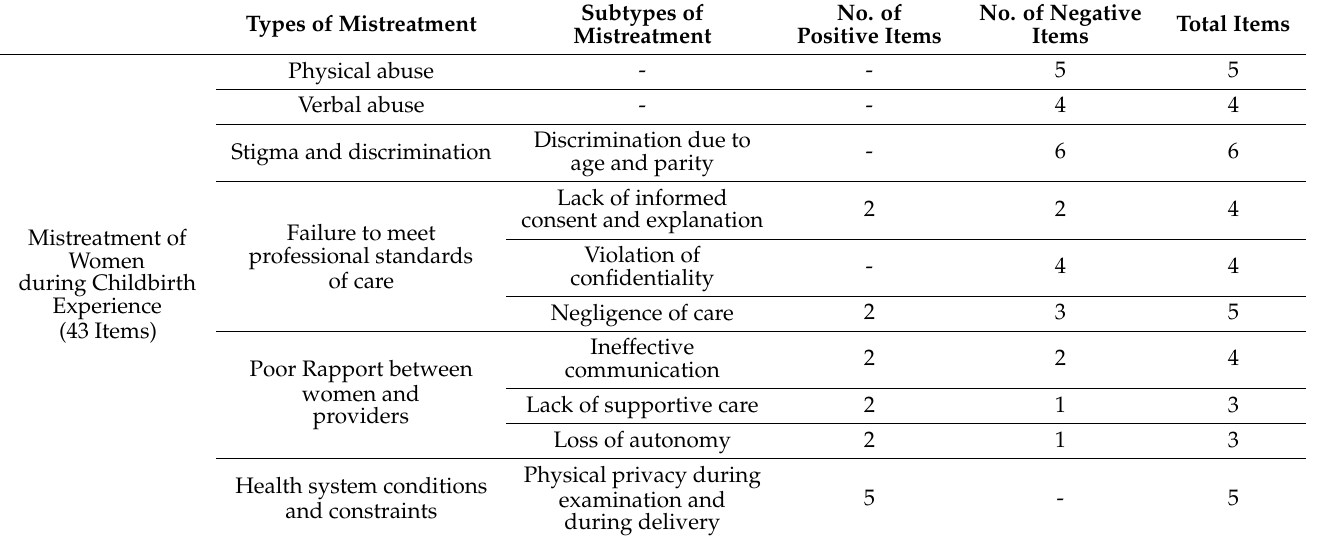
Table 1. The types, subtypes, and positive and negative items included in mistreatment of women during the childbirth